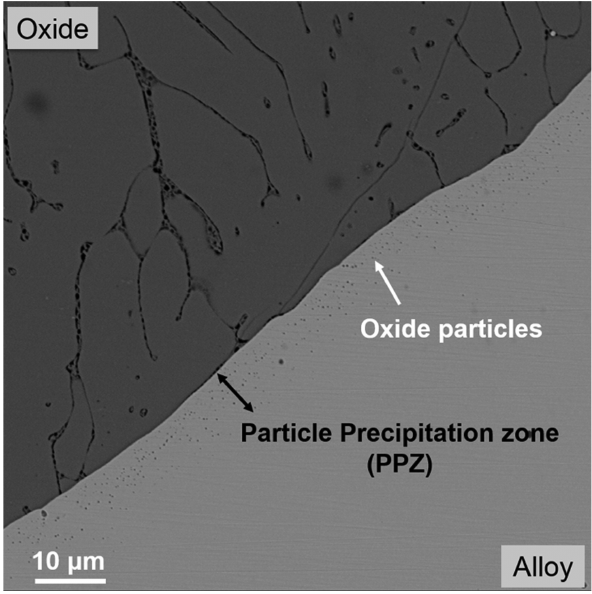
Figure 1: Morphology of the interface between the oxide and alloy before heat